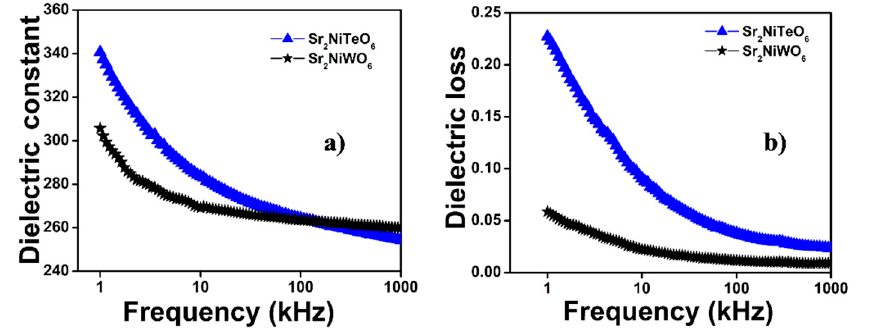
Figure 6. ( a ) Dielectric constant and ( b ) dielectric loss of Sr 2 NiWO 6 and Sr 2 NiTeO 6 ceramics at room